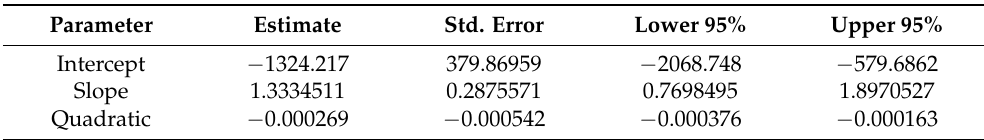
Figure 13. Plotted selected quadratic model of the dependence of the number of holes drilled up to the moment of tool damage on speed change.